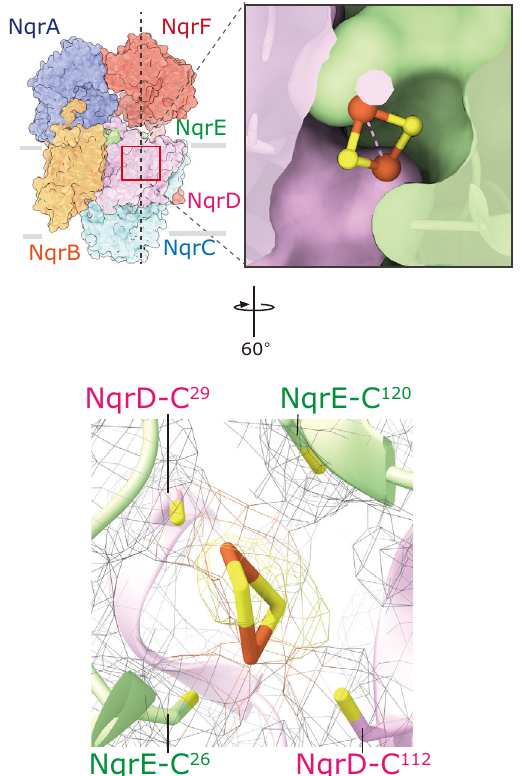
Fig. 3 The putative 2Fe-2S center located between subunits NqrD and NqrE that is so far undetected. The density map at the interface between NqrD and NqrE resembles that of a 2Fe-2S cluster rather than a single iron atom. An upper panel : The 2Fe-2S cluster at the center of the two-fold symmetrical axis of NqrD and NqrE. A lower panel : The two pairs of conserved cysteine residues (NqrD-Cys29/NqrE-Cys120 and NqrE-Cys26 and NqrD-Cys112) coordinate the 2Fe-2S cluster. The Cys residues and 2Fe-2S cluster are shown as sticks and ball-and-sticks models, respectively. In this panel, the consensus map for Na + -NQR is used and shown as a mesh